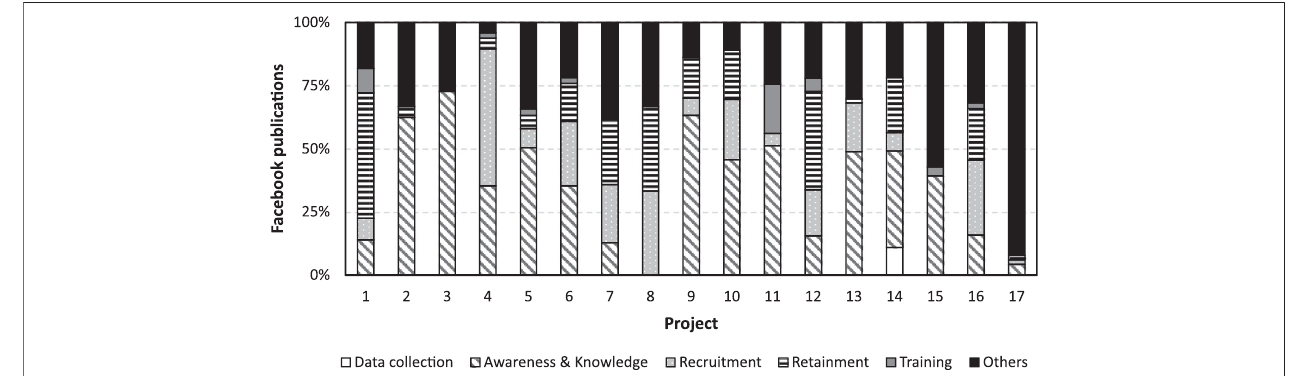
FIGURE 6 | Percentage of posts that represented each citizen science usage for each selected